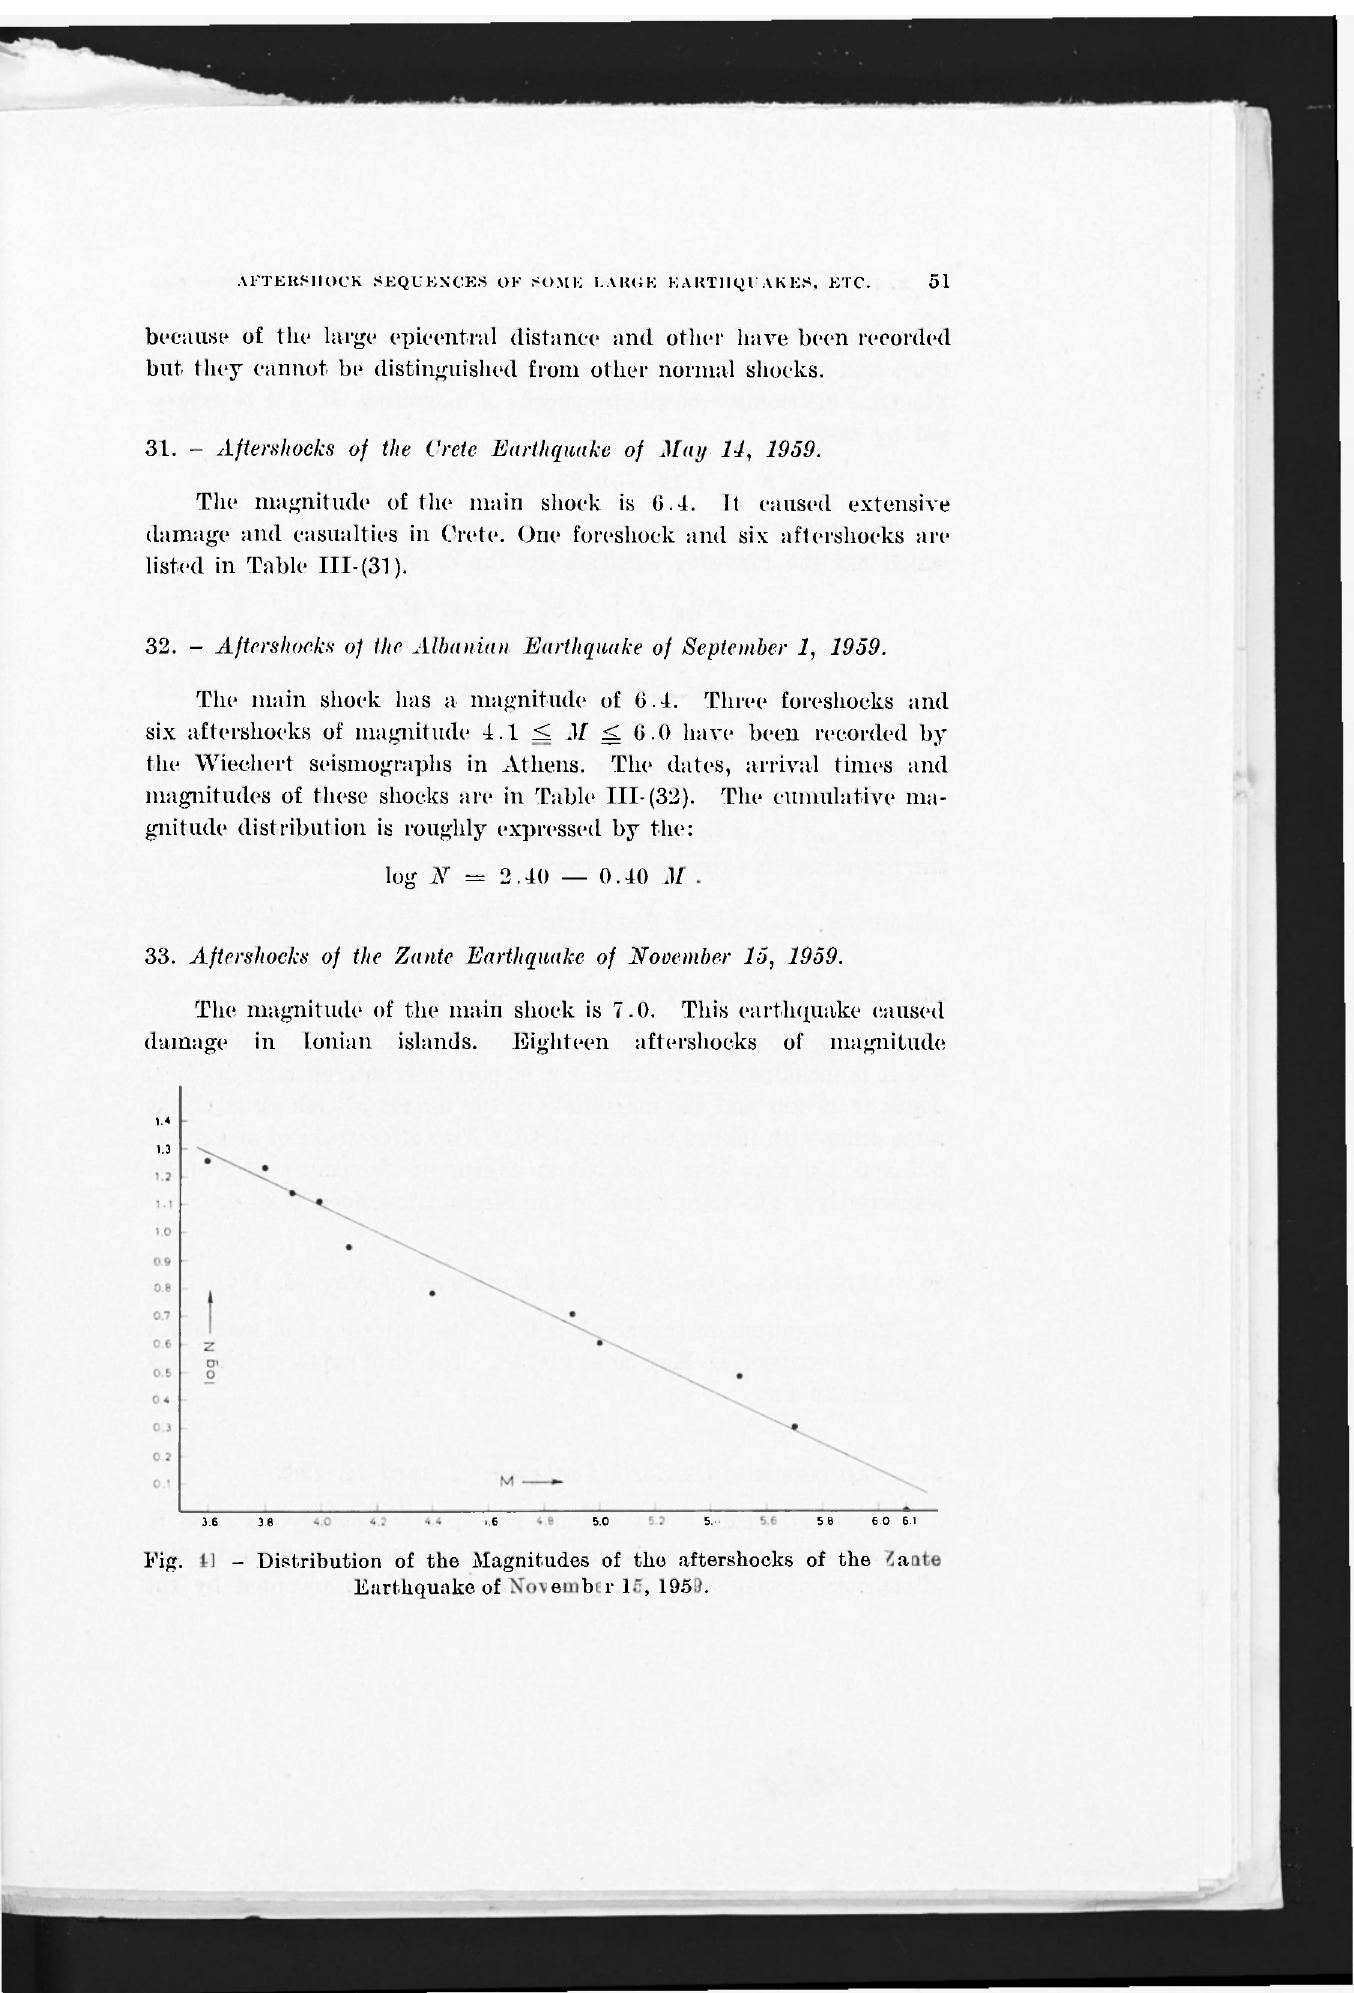
Fig. 35 - Distribution of the Magnitudes of the aftershocks of the Messinia Earthquake of F e b r u a ry 19,